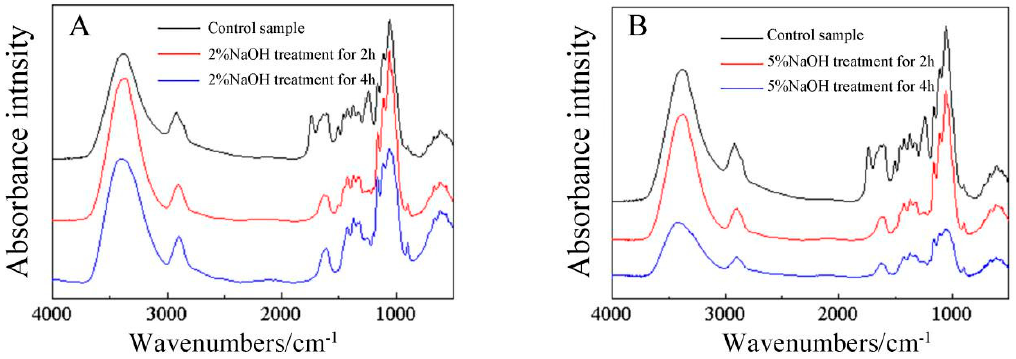
Figure 2. Infrared spectra and local amplified infrared spectra of PCF during chemical purification.